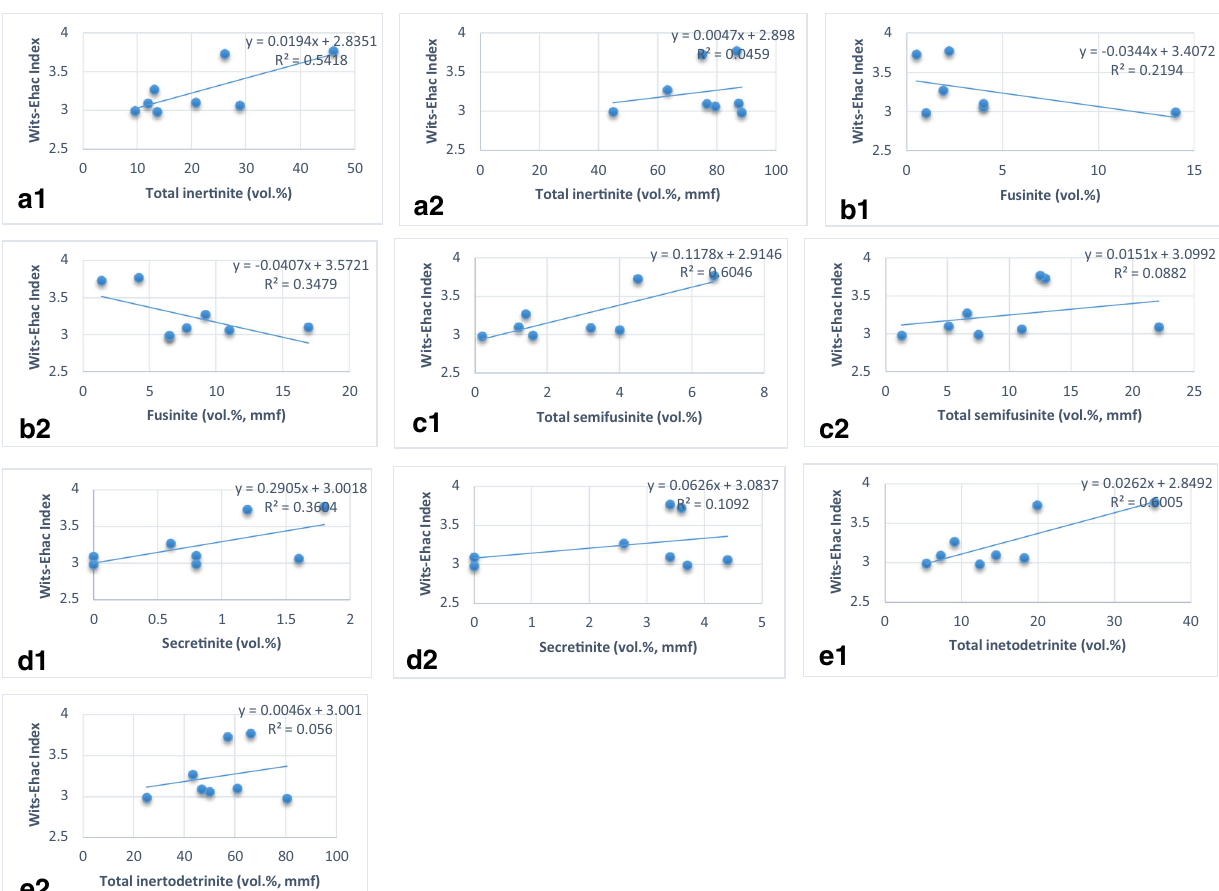
Fig. 11 Influence of inertinite and its group on spontaneous combustion of